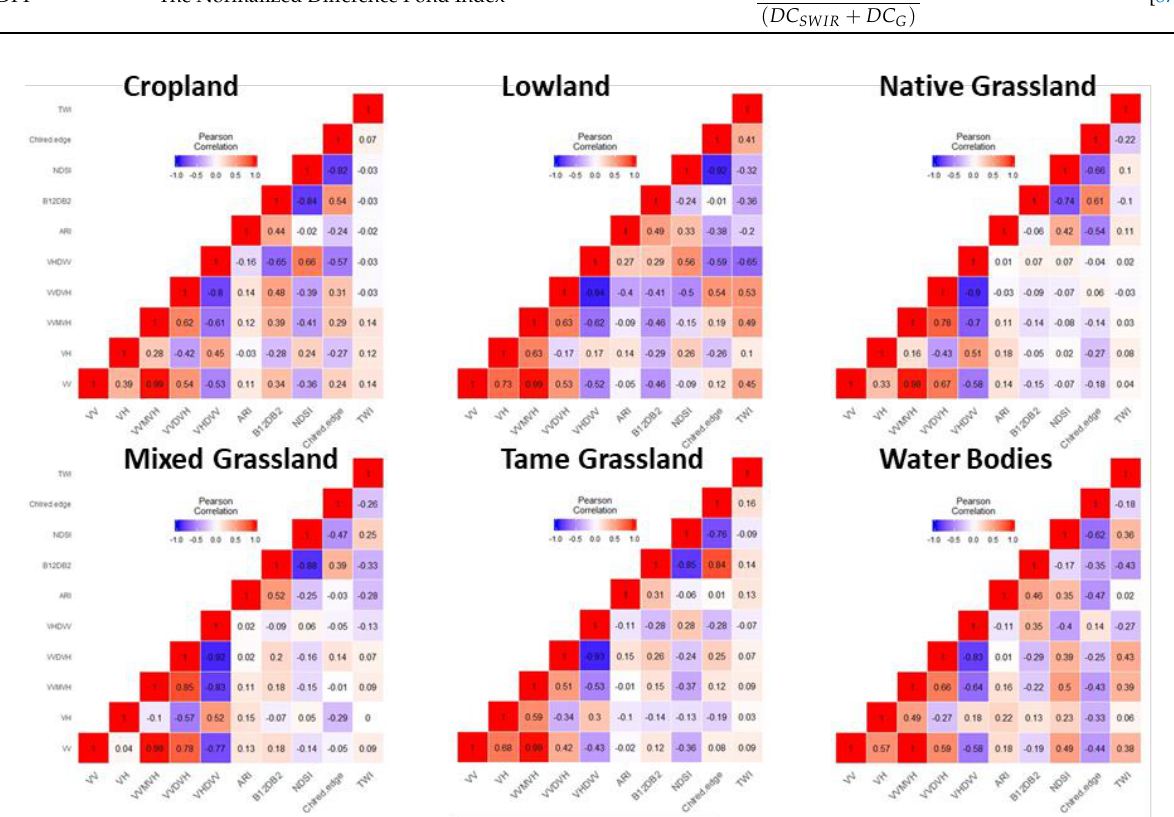
Figure A1. Person correlations between 10 raster-based variables derived from Sentinel-1 and Sentinel-2 for different land cover classes in the SoD (pilot site).